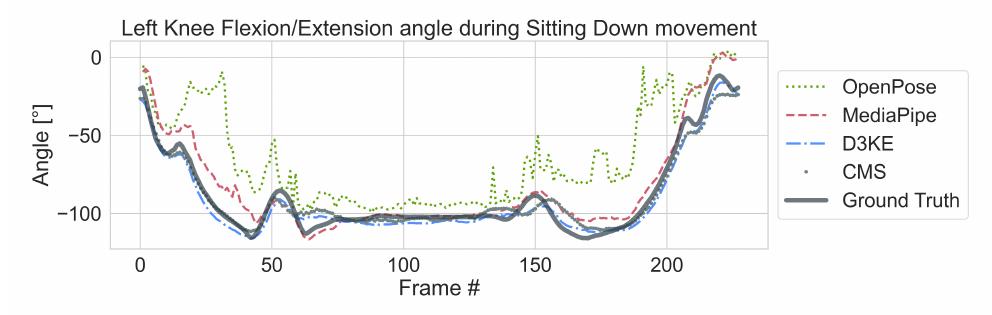
Figure 6. Qualitative comparison of predicted angles of the left knee, from a ’sitting-down’ movement in the BML-Movi dataset. While OpenPose shows by far the noisiest estimation, the smoothing of the MediaPipe estimation is clear, our proposed method and implemented CMS work best, probably due to the restriction of additional